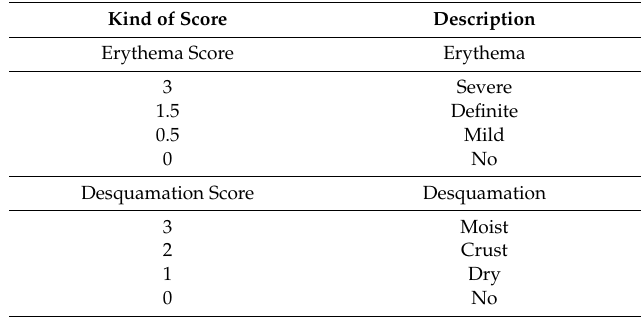
Table 3. Semi-quantitative scores for skin erythema (top) and desquamation (bottom).